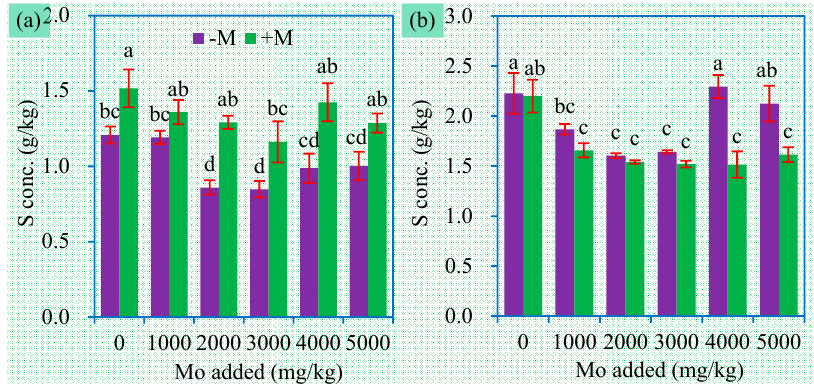
Figure 7. Shoot ( a ) and root ( b ) S concentrations (mean ± SE, n = 4) of sweet sorghum exposed to different concentrations of Mo. -M and +M represent non-AM inoculation and inoculation with Claroideoglomus etunicatum BEG168, respectively. Different letters over the bar represent significant differences between the means among different treatments using one-way ANOVA followed by Duncan’s multiple range test ( p < 0.05). Two-way ANOVA results for shoot S concentrations: AM inoculation: F = 41.9**, Mo: F = 6.7**, AM×Mo: F = 1.0 ns; two-way ANOVA results for root S